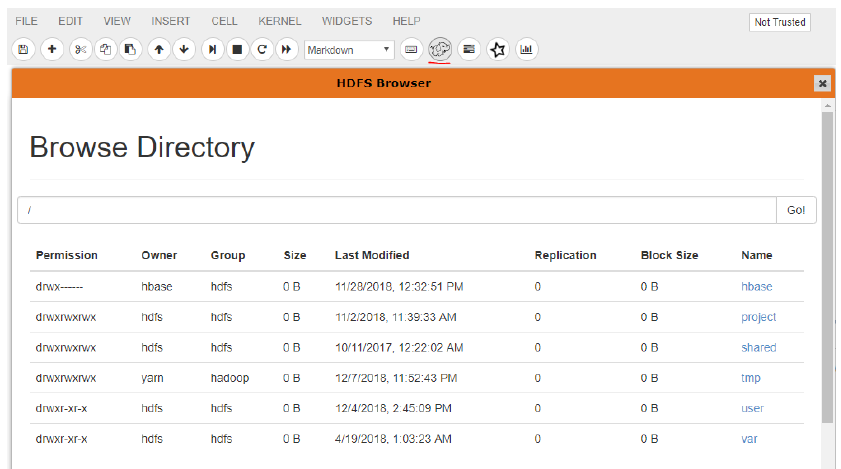
Figure 6 : Browsing the HDFS filesystem from Jupyter